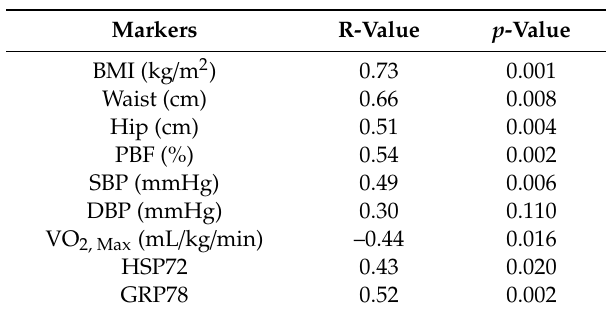
Table 3. Spearman correlation with EPHX2